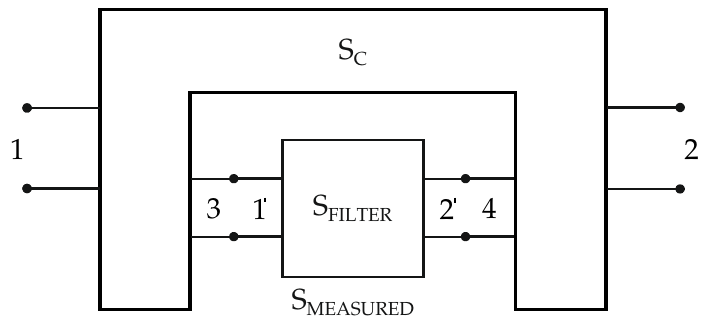
Figure 9. Schematic representation of the de-embedding procedure with port definition for the intrin- sic band-stop filter: Filter embedding block diagram.